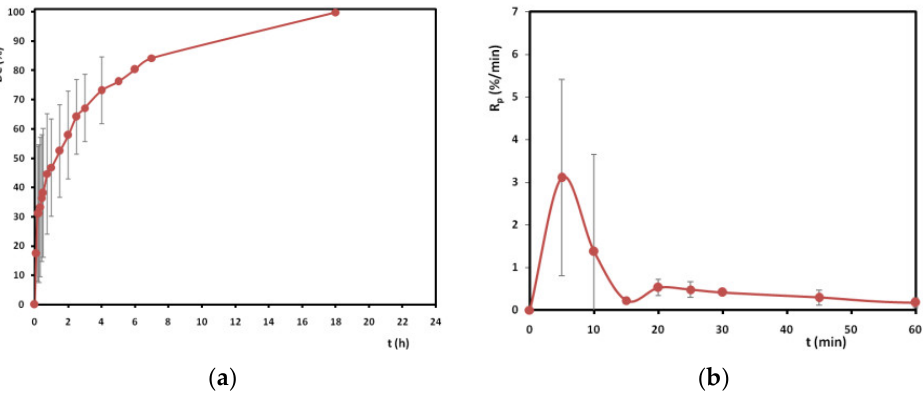
Figure 4. DC% over time for the 1st day of curing ( a ) and rate of DC% increase for the 1st hour of Figure 4. DC % over time for the 1st day of curing ( a ) and rate of DC % increase for the 1st hour of curing ( b ). curing ( b